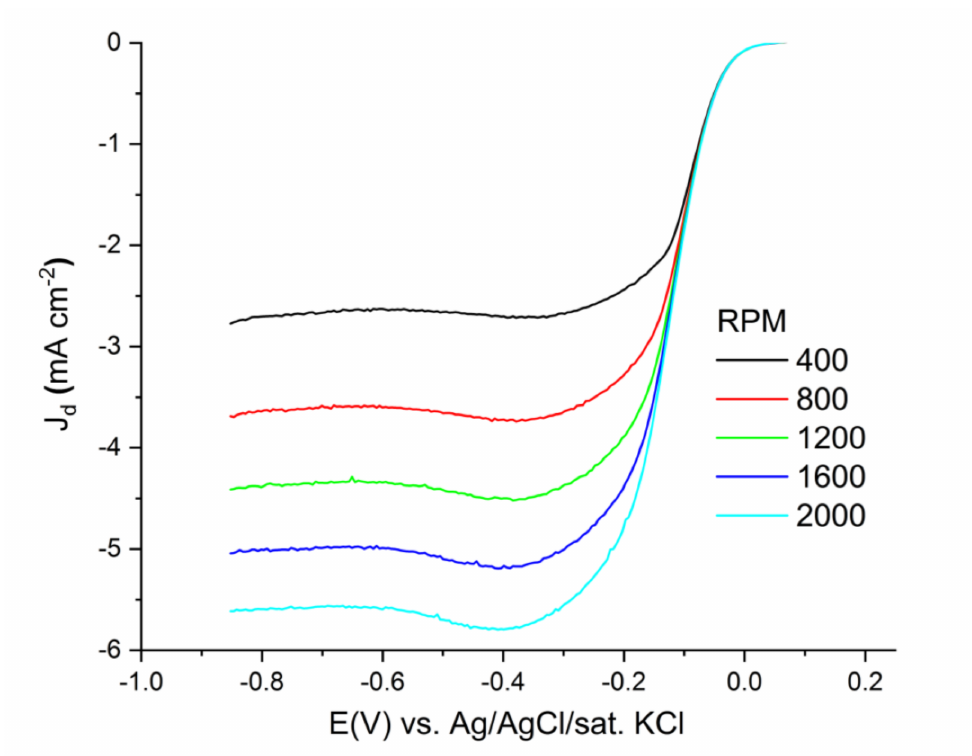
Figure 6. LSVs (linear sweep voltammograms) recorded at di ff erent spin rates (400; 800; 1200; 1600; 2000 rpm) at 20 mV / s scan rate of sample